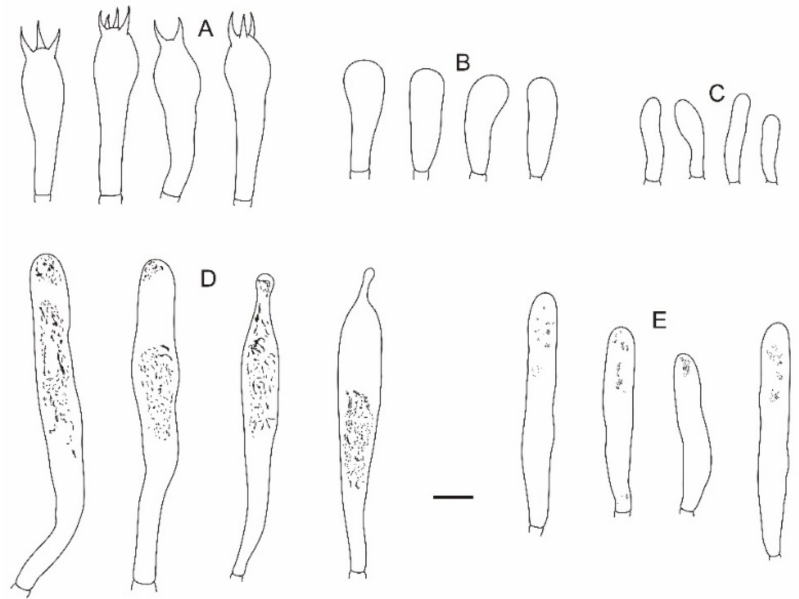
Figure 16. Microscopic features of Russula sinorobusta (BJTC Z052). ( A ) Basidia. ( B ) Basidiola. ( C ) Marginal cells. ( D ). Hymenial cystidia on lamellae sides. ( E ) Hymenial cystidia on lamellae edges. Scale bar: 10 µ m.